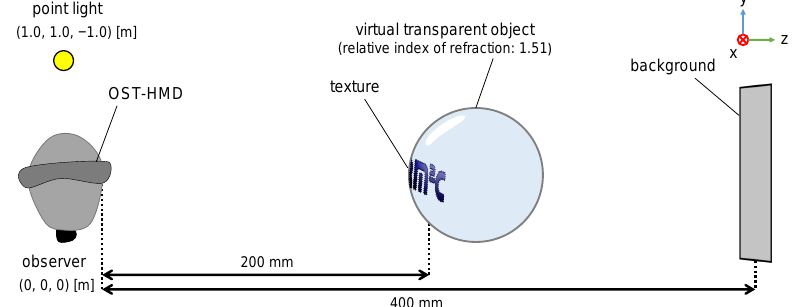
Figure 10. Environment for determining gaze